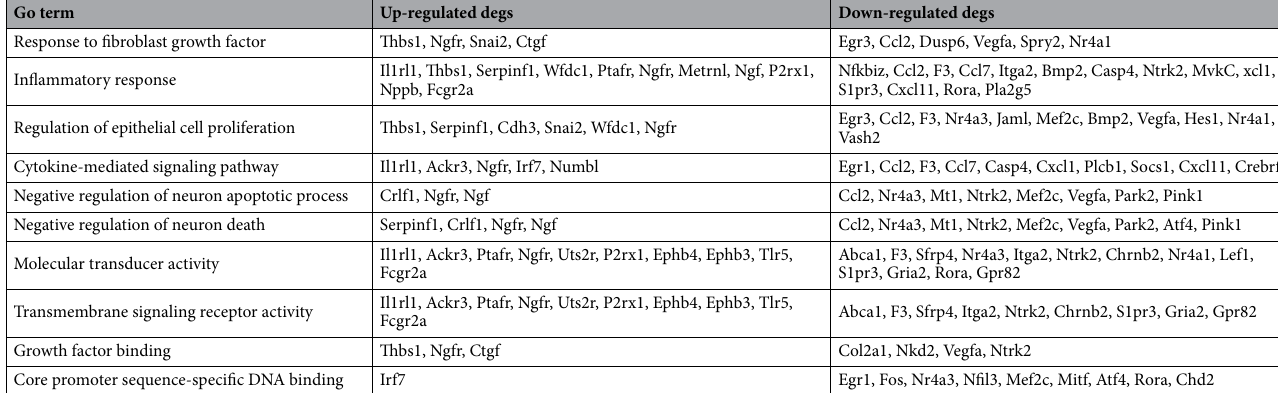
Table 2. Most up-regulated and down-regulated DEGs involved in important GO